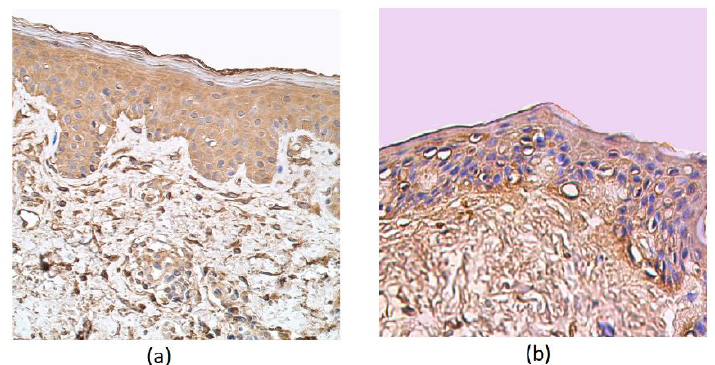
Figure 4. Immunohistochemical micrographs in rosacea-affected tissues and in control samples. ( a ) Note the moderate LL-37-containing epithelial cells and only connective tissue cells in a 35-year-old female. LL-37 IMH, X 250; ( b ) a few positive structures in the epithelium and connective tissue of the control group of a 66-year-old male. LL-37 IMH, X 200.